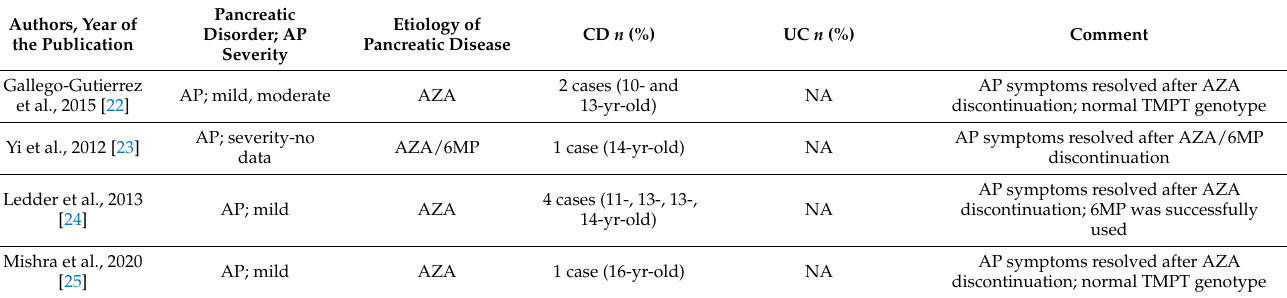
Table 2. Pancreatic disorders reported in children with IBD based on case